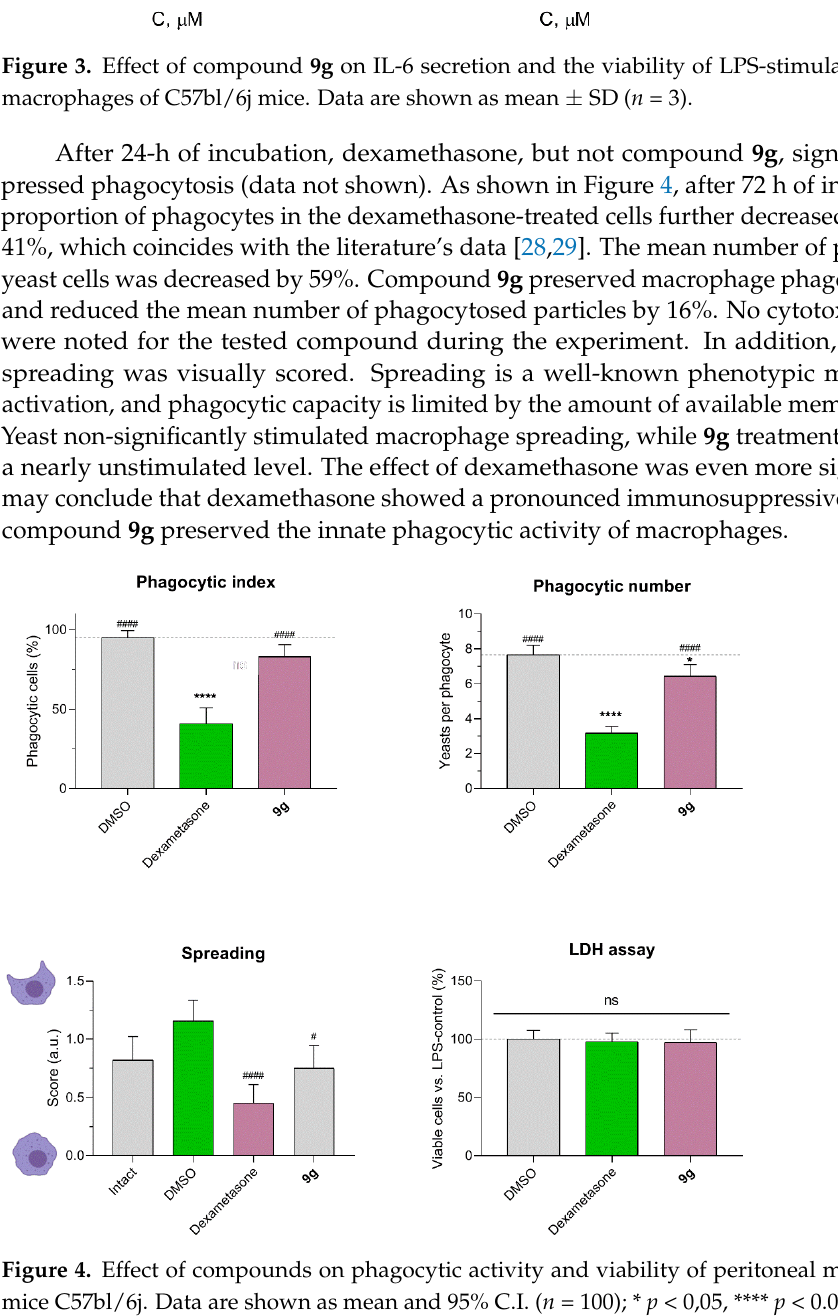
Given the promising cellular data, we studied the protective activity of lead com- pound 9g in a model of LPS-induced acute lung injury. The randomization of C57bl/6j mice into experimental and control groups was based on body weight and behavioral activity assessed in an open field test 24 h before the start of the experiment. The next day, mice were treated with vehicle or test compounds 1 h before intratracheal instilla- tion of LPS solution in sterile saline. The behavioral activity of animals was followed 2 and 24 h after LPS administration with an open field test. LPS-treated mice showed a pronounced decrease in motor activ- ity accompanied by lethargy and sedation (Figure 5). Horizontal motor activity at the 2-h point demonstrated a significant decrease relative to intact control that received saline only. Motor alterations persisted for up to 24 h. For mice from the LPS + dexamethasone group, a decrease in horizontal activity was observed after 2 h, comparable to that of the LPS group, but at the 24-h point, a significant improvement was evident. Compound 9g also restored motor activity of animals comparably to dexamethasone. We observed similar trends in exploratory behavior as well. LPS-treated mice avoided the center of the field, while both dexamethasone and 9g restored the number of center entries and time in the center to intact levels.